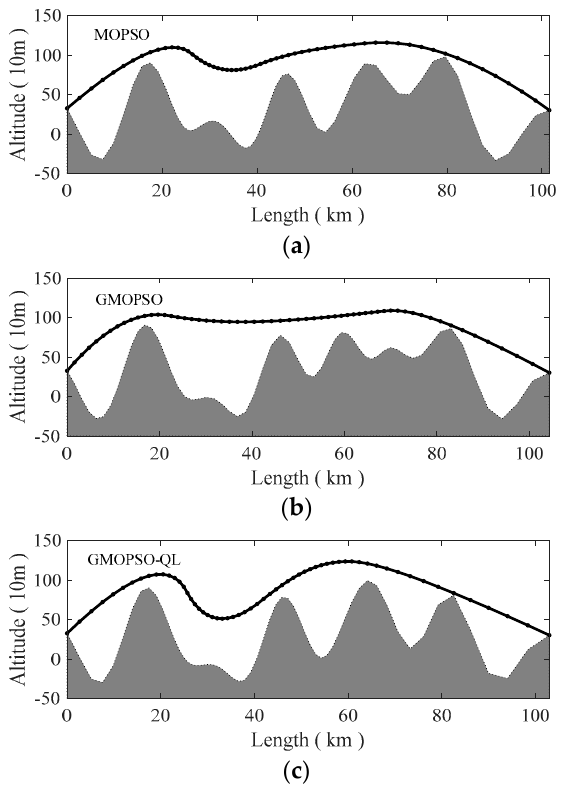
Figure 10. The vertical profiles of the best paths in Case 2: ( a ) MOPSO, ( b ) GMOPSO, ( c ) GMOPSO-QL.